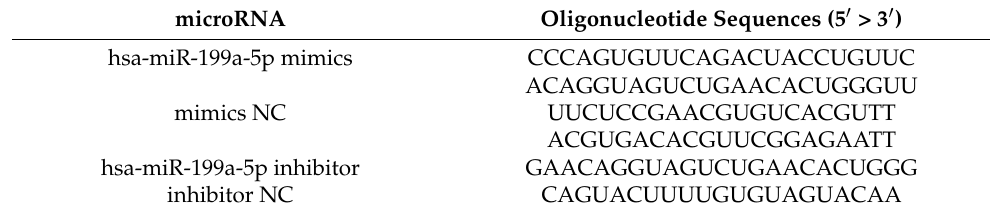
Table 1. Oligonucleotide Sequences of